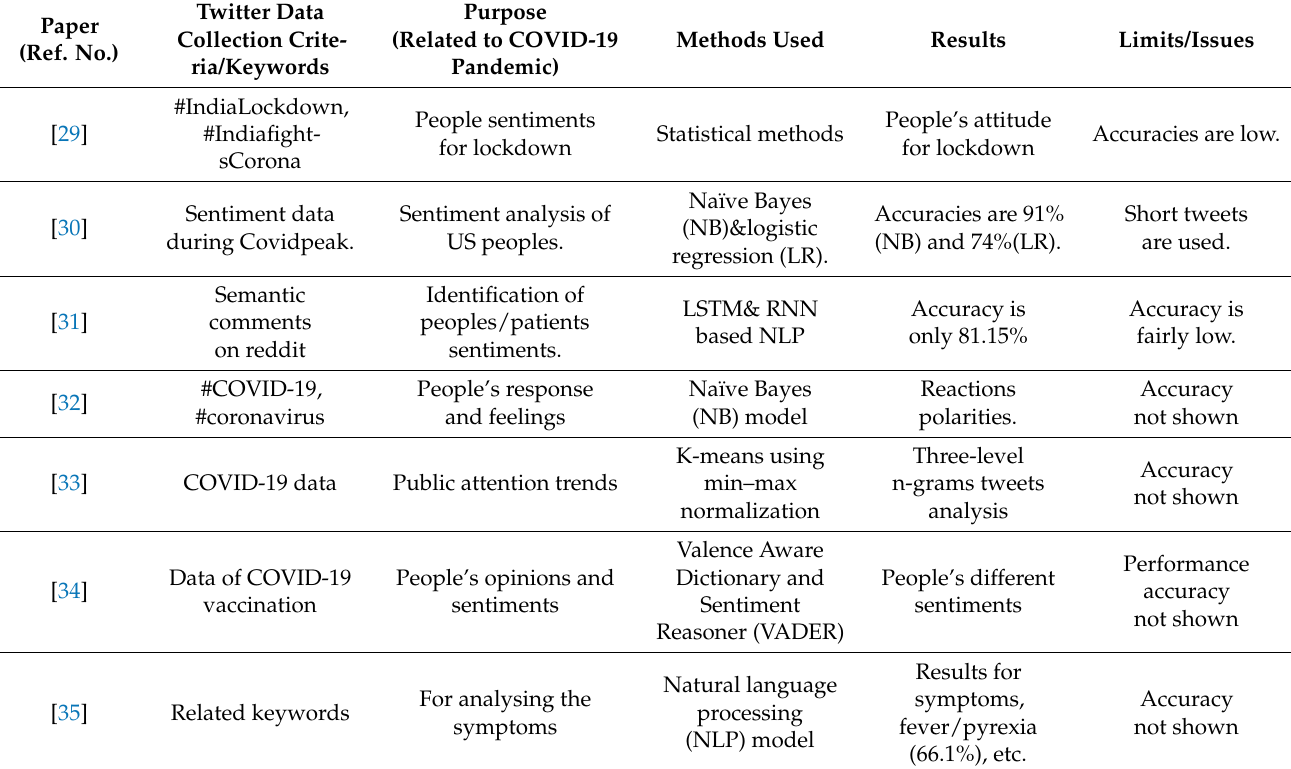
Table 1. Summary of literature review related to